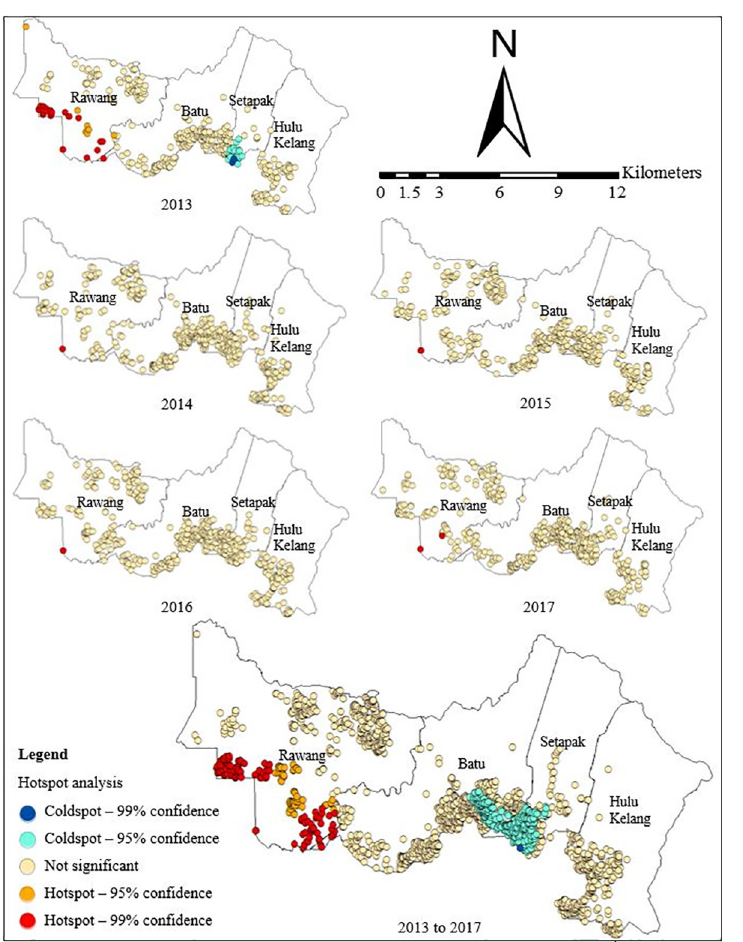
Fig 7. The hotspot analysis of TB cases in Gombak, 2013 to 2017.